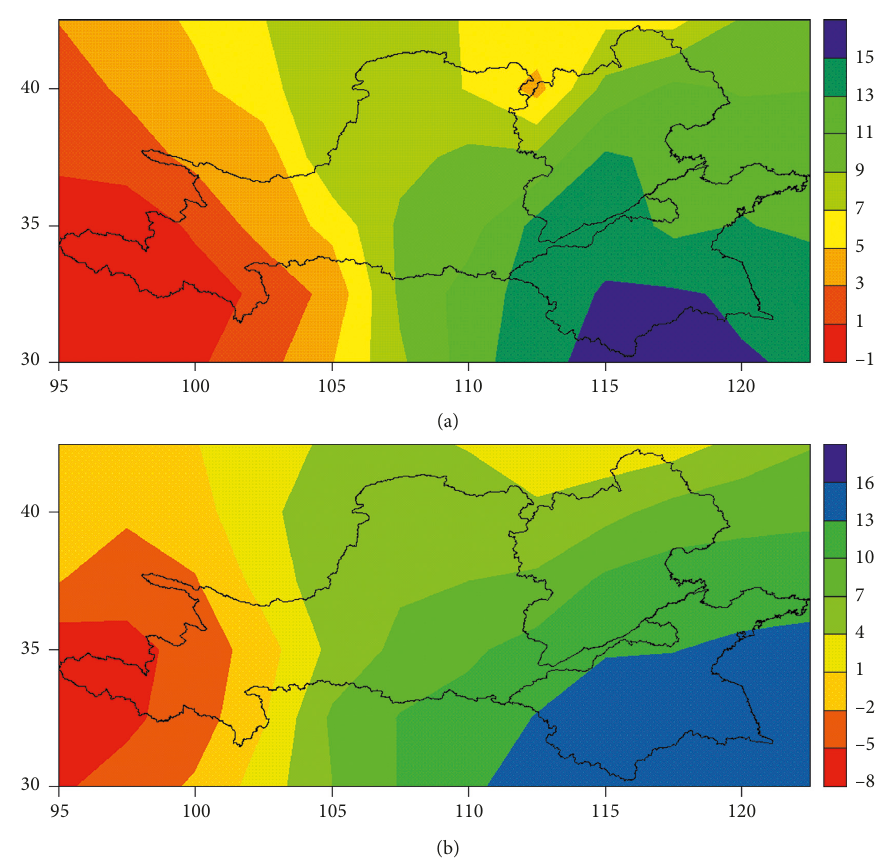
Figure 2: Spatial distribution of annual temperature: (a) observations; (b) simulations for all